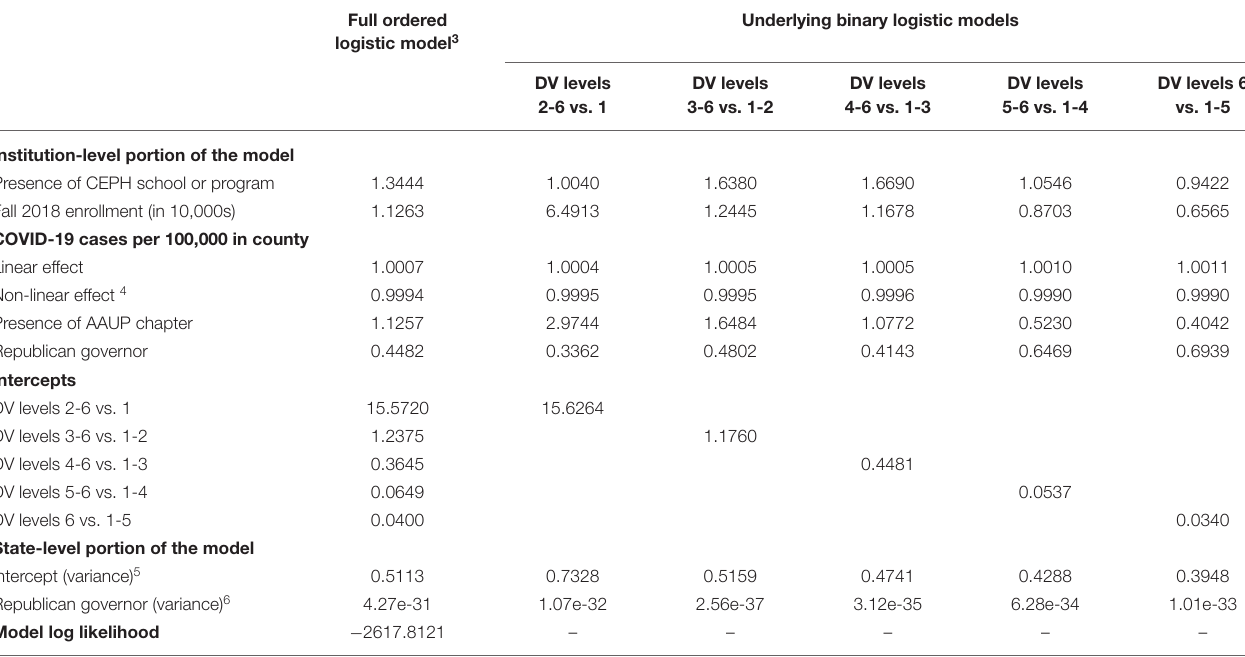
TABLE 2 | Mixed effect logistic regression models predicting the level of restriction on teaching modalities 1,2